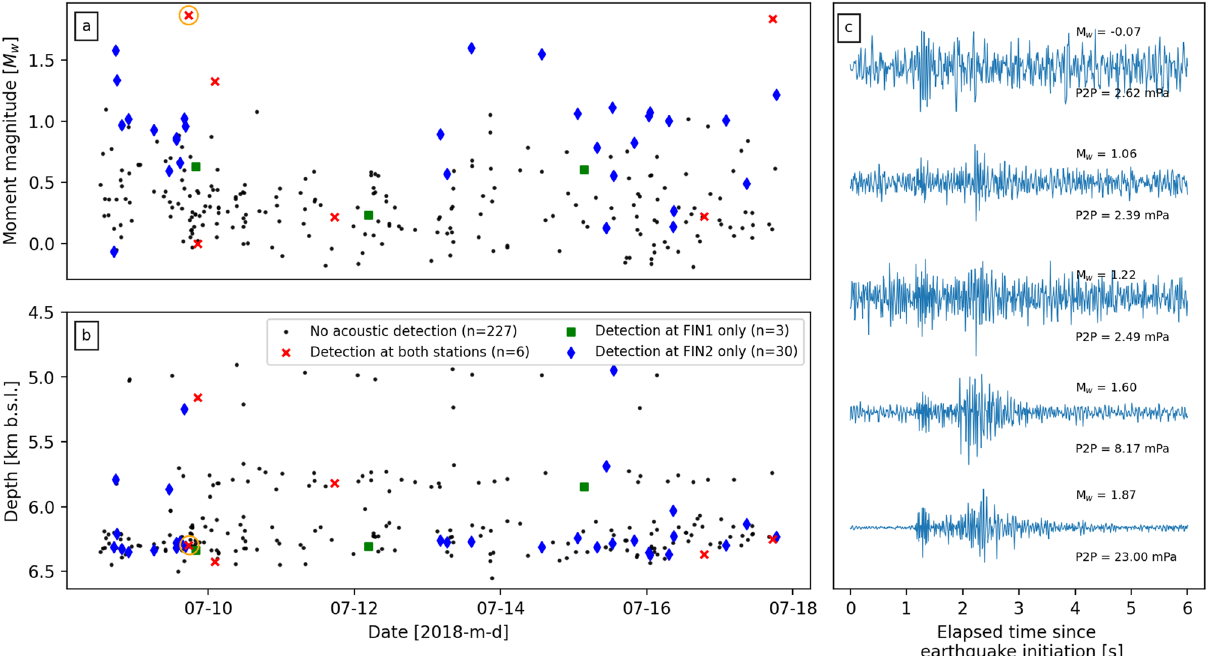
Figure 2. Moment magnitudes ( a ) and depths ( b ) of the 266 relocated seismic events recorded during the infrasound array deployment near the St1 Deep Heat Oy EGS project. Red ‘x’, green squares, and blue diamonds indicate the events which were detected by both acoustic arrays, only at FIN1, or only at FIN2, respectively. Orange circle in each panel indicates the M w 1.87 event described in detail in Figs. 3 and 4. ( c ) 6 s of normalised acoustic data (highpass filtered at 5 Hz) recorded by sensor 2 at FIN2 after the initiation of five example earthquakes, including the lowest and highest magnitude events. Calculated M w and recorded peak-to-peak pressure amplitudes (P2P) of each event is indicated on the right; each event was located at 6.2–6.3 km depth (see Figs. S2 to S11 in Supporting Information for waveforms and frequency spectrograms from all microphones for each